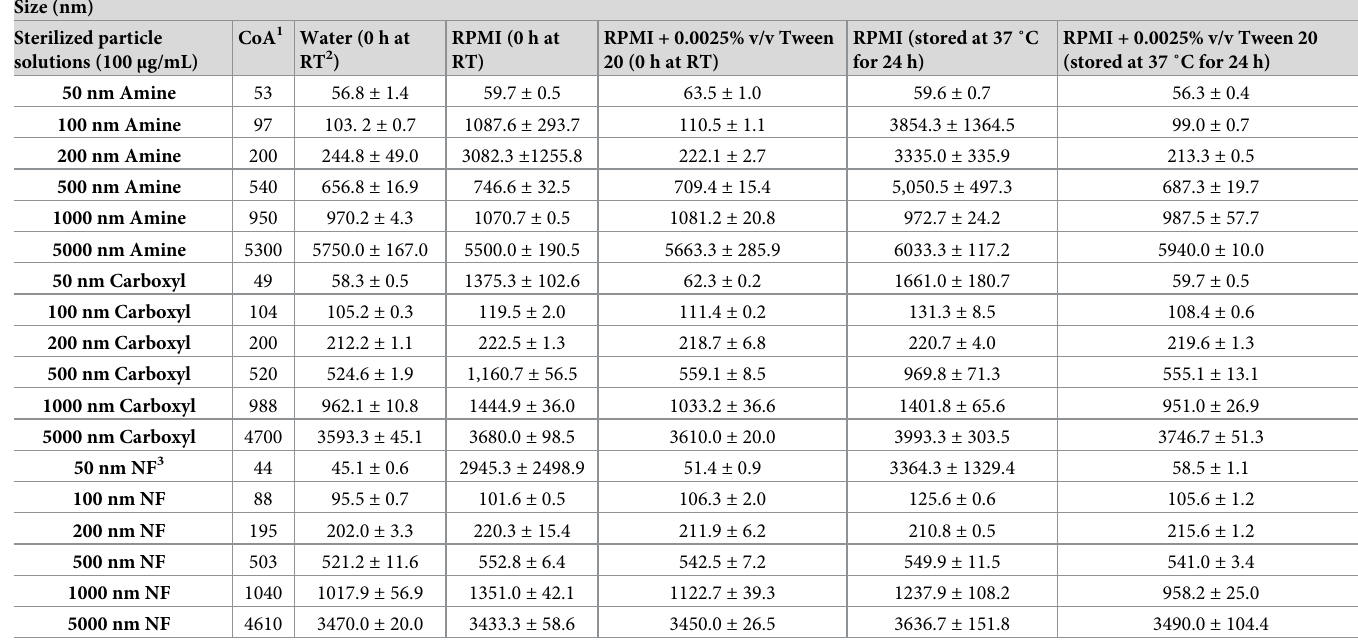
Table 1. Effect of matrix and storage conditions on particle size of polystyrene micro/nanoplastics (mean ± S.D.; n = 3). Size (nm) Sterilized particle solutions (100 μ